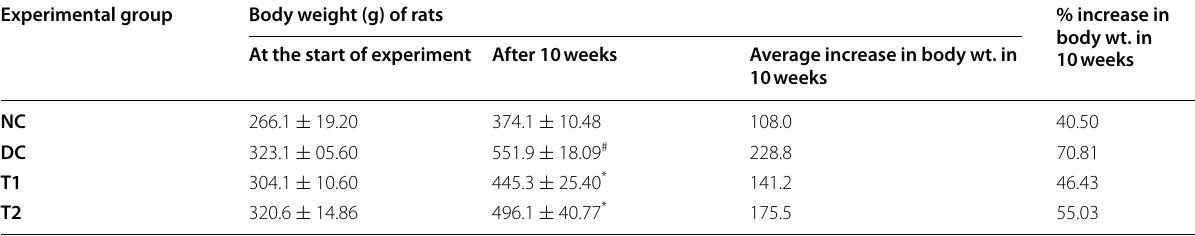
Values are expressed as mean SD ( n 6). # Significantly ( p < 0.05) different from Normal Control. * Significantly ( P < 0.05) different from Disease Control. Statistical ± = analysis was performed by applying one-way ANOVA followed by Dunnet’s Test using Graph Pad Prism V6.0. Statistical significance was kept at P < 0.05. NC Normal control, DC Disease control, T1 Probiotic fermented milk with WPC and SPI, T2 Probiotic fermented milk without WPC and SPI